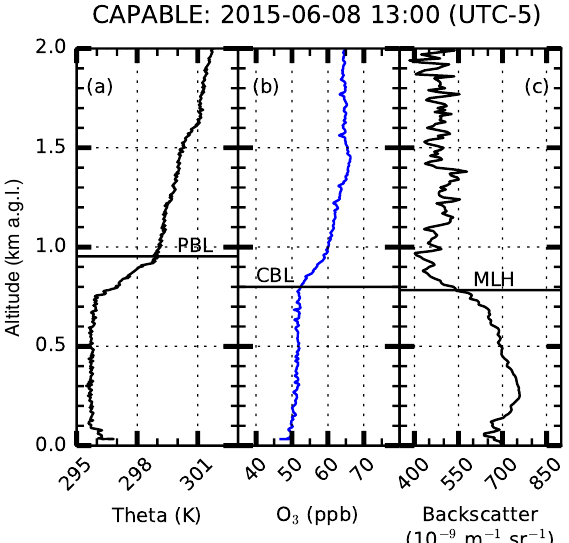
Figure 2. Potential temperature, ozone, and backscatter profiles recorded on 8 June 2015. The horizontal lines indicate the ABL, CBL, and MLH at 13:00 local